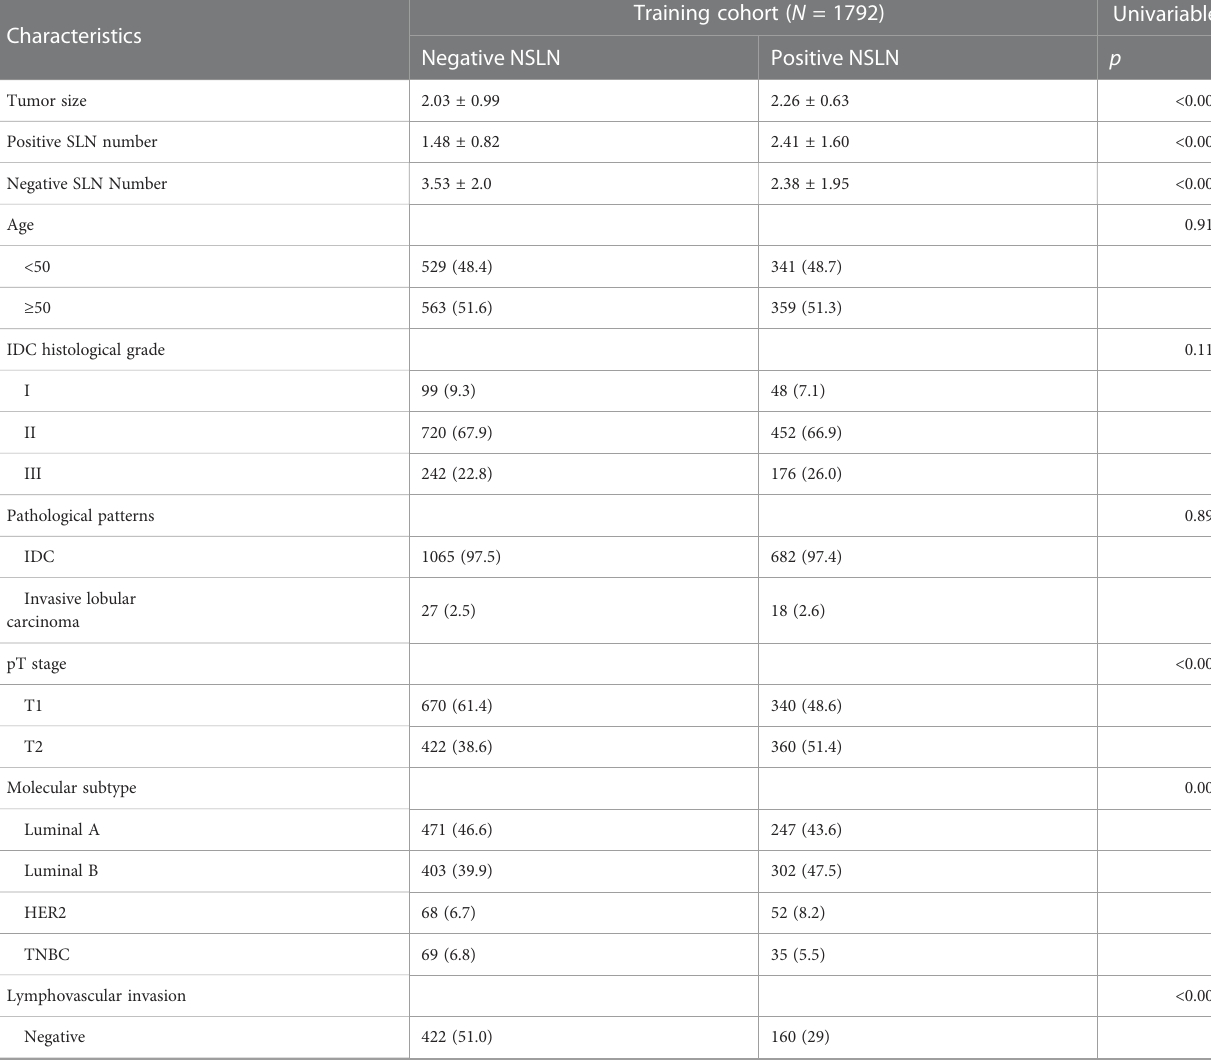
TABLE 2 Univariate analyses of positive non-sentinel lymph nodes in the training